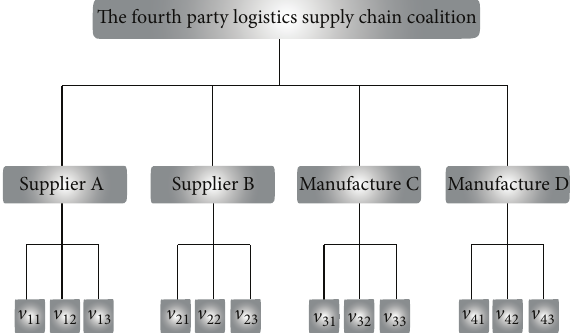
Figure 2: The hierarchical structure model.